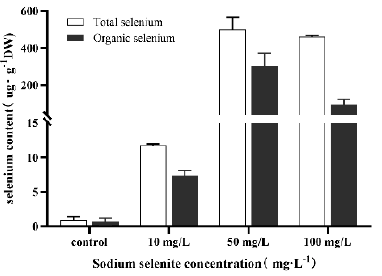
Figure 4. Total selenium and organic selenium content in D. salina treated with